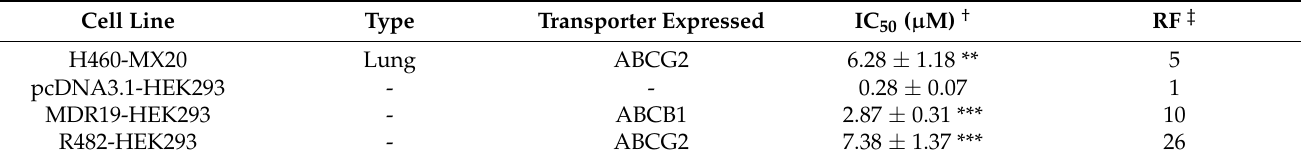
more than three independent experiments; bars,